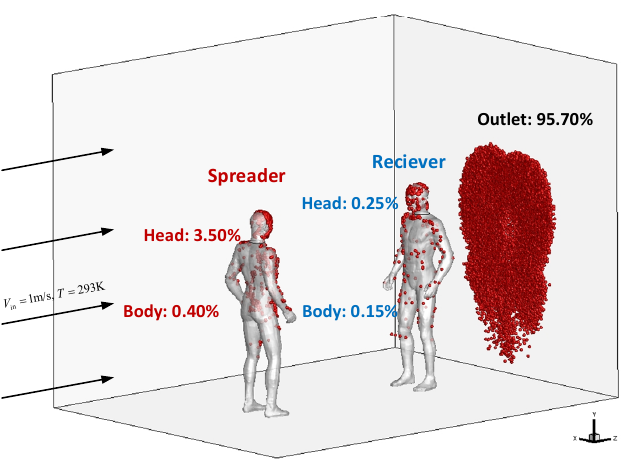
Figure 7. Deposition of 0.3 µ m particle in Condition A.